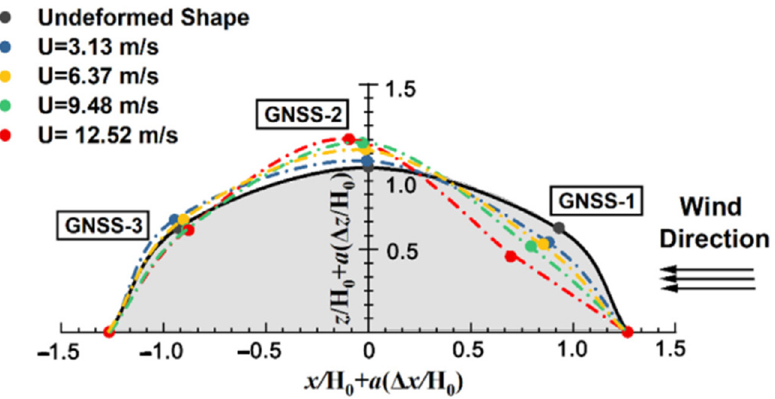
Figure 12. Structural deformation under different wind speeds (side view) [19].